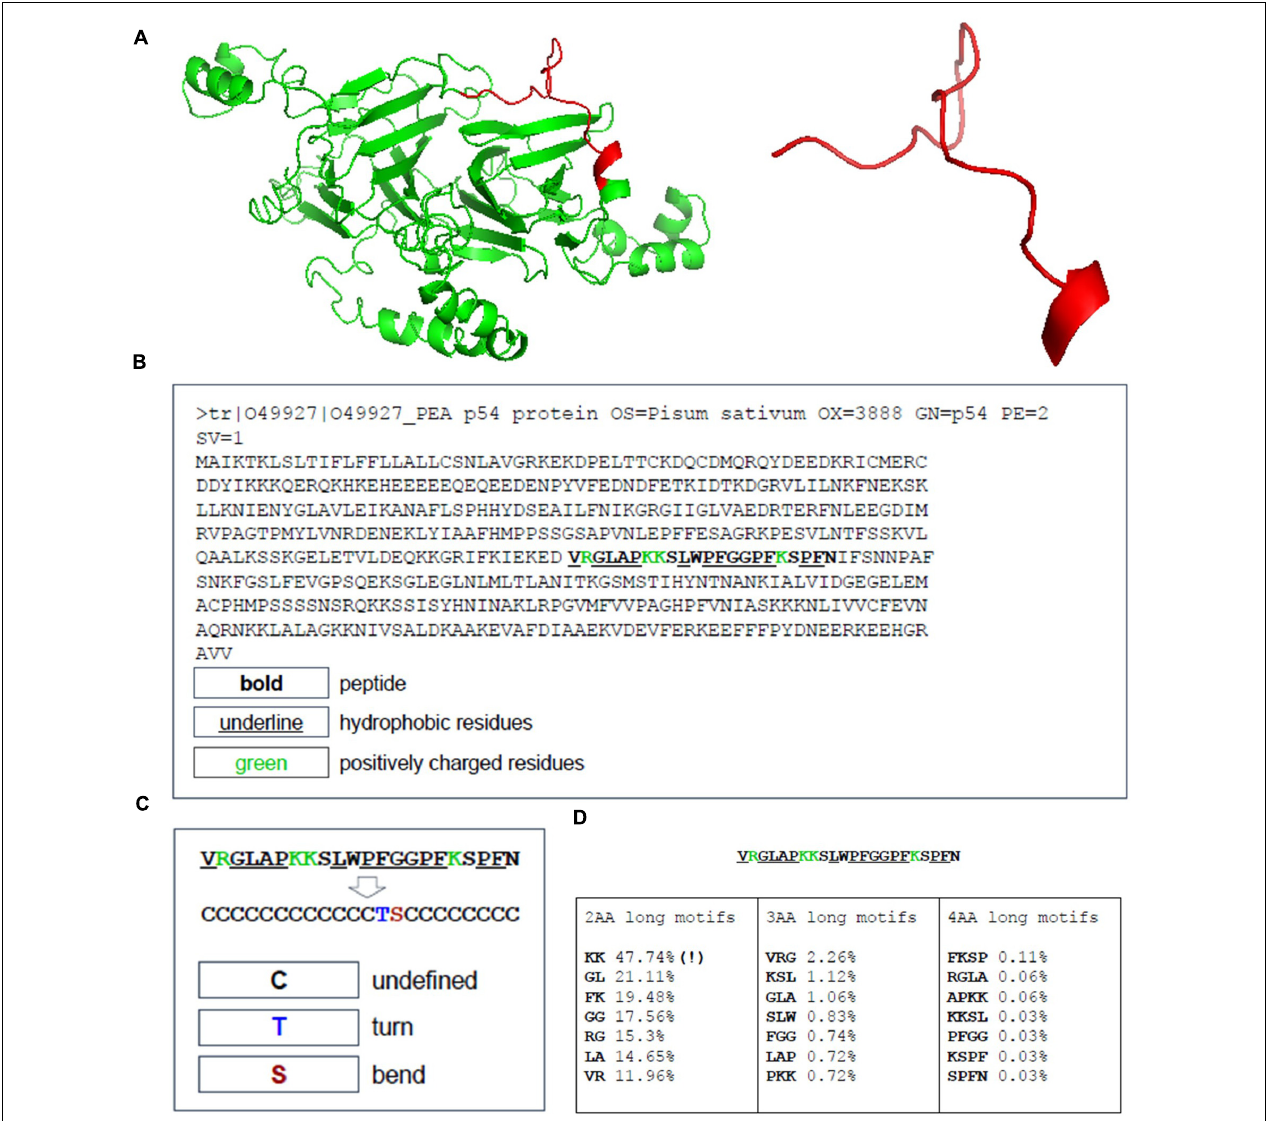
FIGURE 3 | Sequence Location, structure and antimicrobial motifs of NuriPep 1653 derived from P54 Pisum sativum protein. The sequence structure and folding pattern as predicted by I-TASSER is shown in (A) . The sequence of the storage reservoir P54 protein with the location of NuriPep 1653 highlighted in bold, hydrophobic residues underlined and positive resides in green (B) . The peptide conformation is shown in (C) as determined by SCRATCH-1D. The most recurrent exact motifs of length 2, 3, and 4 amino acids within NuriPep 1653 and occurring in 3496 curated antimicrobial peptides are shown in (D)